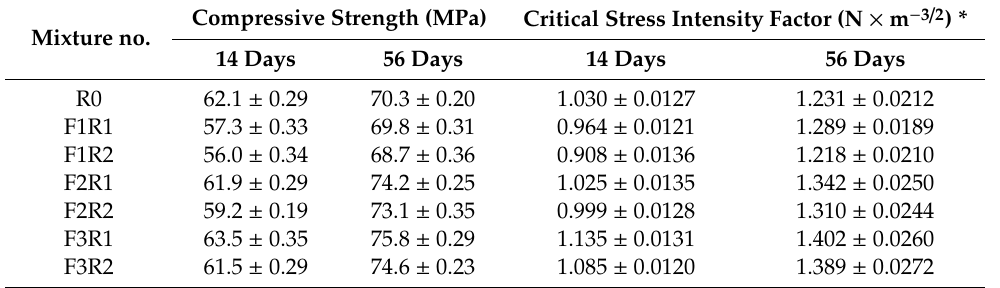
Table 6. Critical stress intensity factor of concrete.